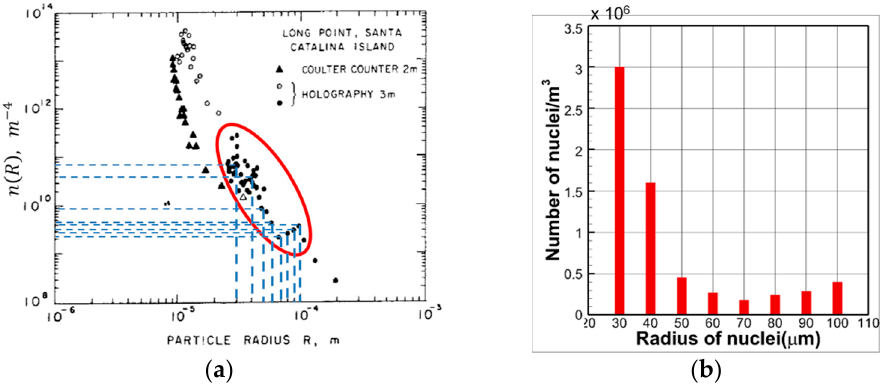
Figure 4. Number concentration density distribution of nuclei as a function of the nuclei radius in Santa Catalina Island. ( a ) Measured data by O’Hern et al. [19]. ( b ) Extracted data from ( a ).